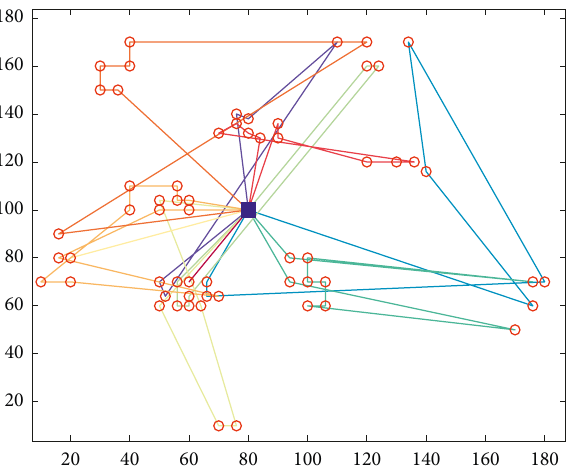
Figure 7: Optimal route for the genetic algorithm.